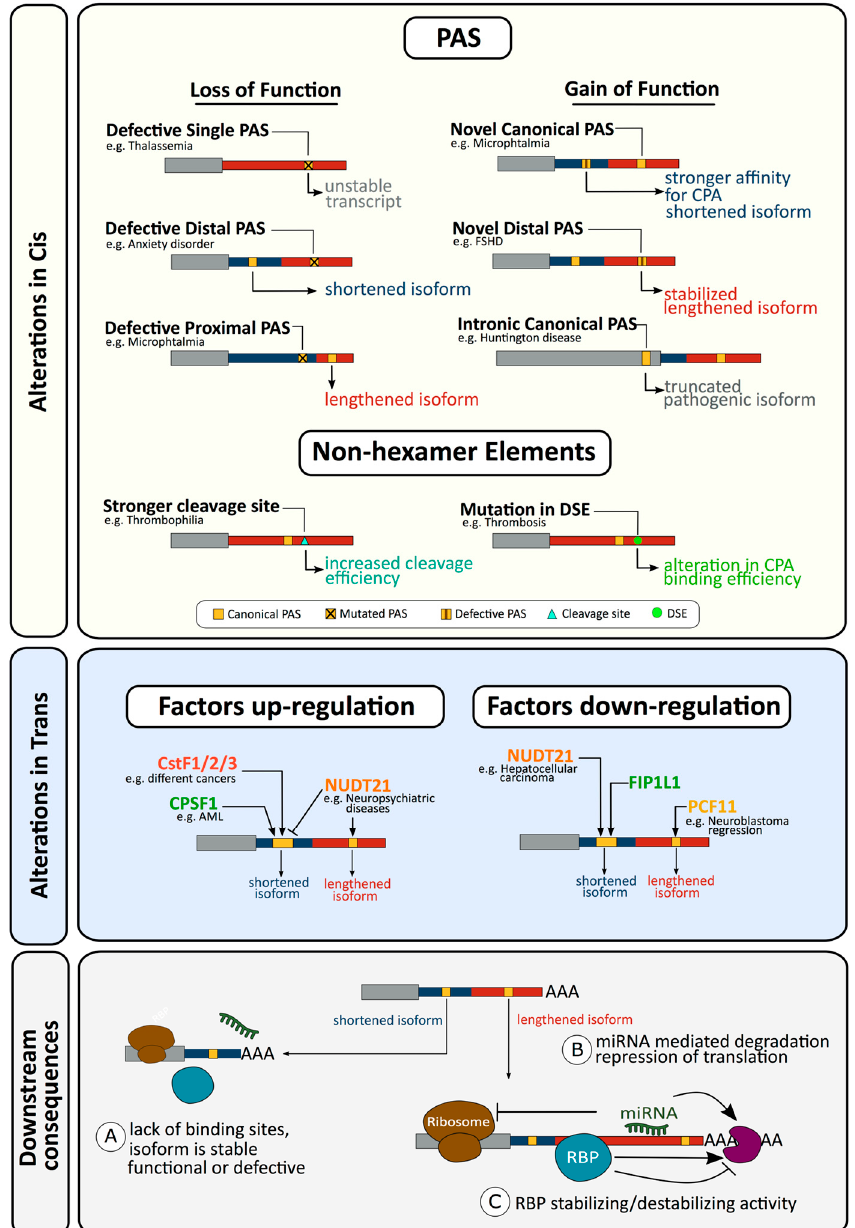
Figure 2. Examples of CPA and APA alterations resulting in disease. Alterations can occur in cis (top panel) or in trans (middle panel) resulting in differing 3 ′ UTR isoforms which in turn offer different platforms for regulation of expression (bottom panel, further details see text and Table 1).